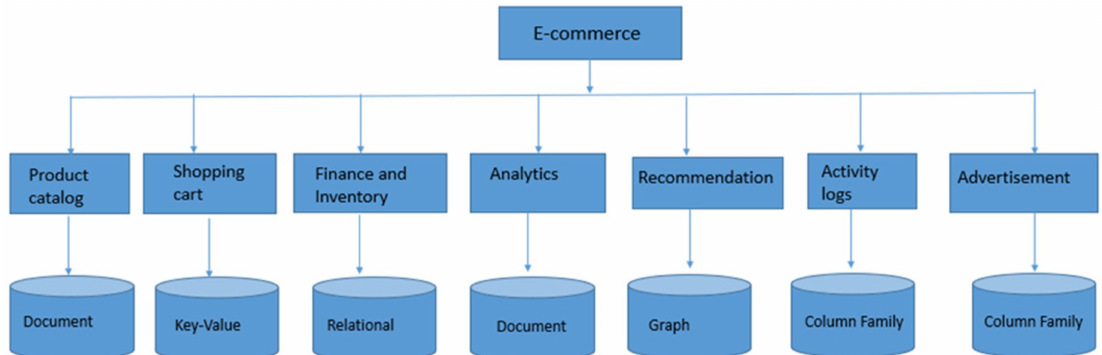
Figure 4. E-commerce System Example for Polyglot Persistence